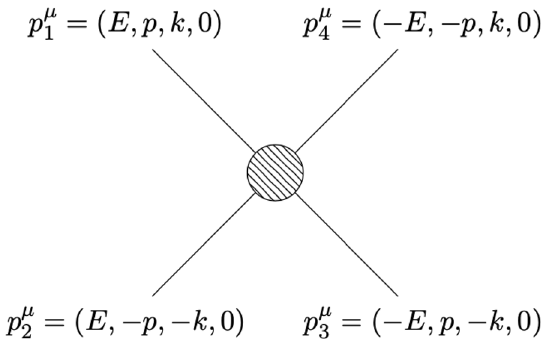
Figure 1 . 2 → 2 scattering in Breit